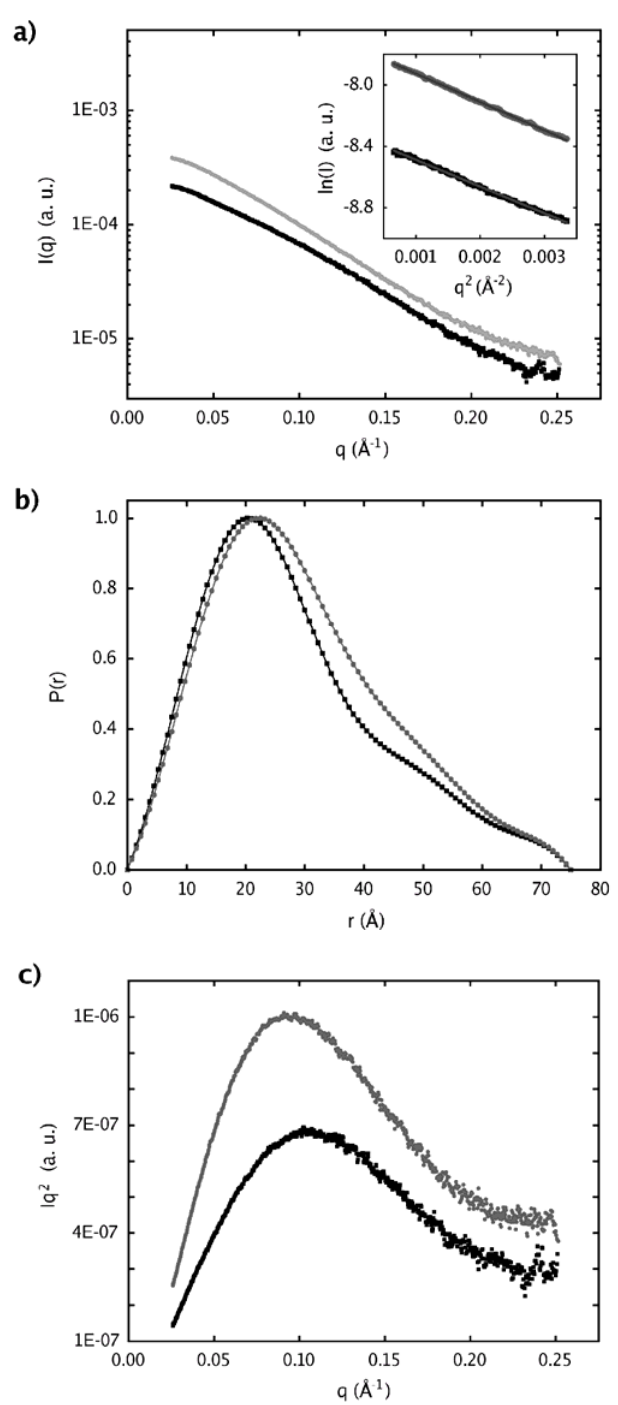
Figure 6. Small Angle X-ray Scattering data plots. (a) Experimental scattering curves and Guinier region with its linear data fit. (b) Distance distribution functions, p(r). (c) Kratky plot. Black squares represent the SAXS data for the native protein (sPLA2, ~4 mg/mL), and the SAXS data for the protein after treatment with naringin (sPLA2-Nar, ~7 mg/mL) are shown as gray